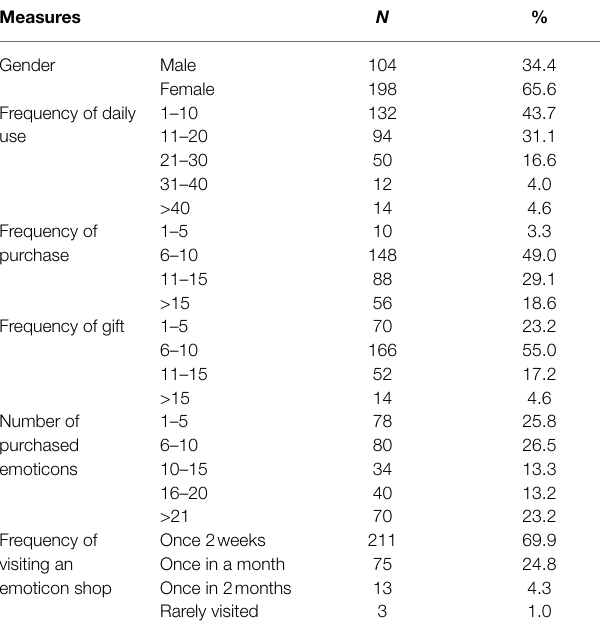
TABLE 2 | Demographics of participants.